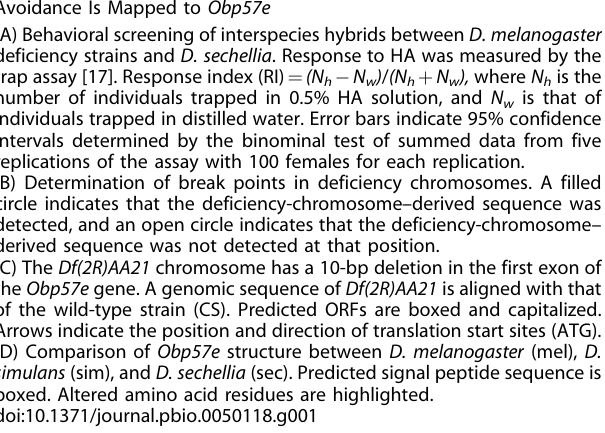
Figure 1. The Locus Responsible for Interspecies Difference in HA Avoidance Is Mapped to Obp57e (A) Behavioral screening of interspecies hybrids between D. melanogaster deficiency strains and D. sechellia . Response to HA was measured by the trap assay [17]. Response index (RI) ¼ (N h (cid:2) N w ) / (N h þ N w ), where N h is the number of individuals trapped in 0.5% HA solution, and N w is that of individuals trapped in distilled water. Error bars indicate 95% confidence intervals determined by the binominal test of summed data from five replications of the assay with 100 females for each replication. (B) Determination of break points in deficiency chromosomes. A filled circle indicates that the deficiency-chromosome–derived sequence was detected, and an open circle indicates that the deficiency-chromosome– derived sequence was not detected at that position. (C) The Df(2R)AA21 chromosome has a 10-bp deletion in the first exon of the Obp57e gene. A genomic sequence of Df(2R)AA21 is aligned with that of the wild-type strain (CS). Predicted ORFs are boxed and capitalized. Arrows indicate the position and direction of translation start sites (ATG). (D) Comparison of Obp57e structure between D. melanogaster (mel), D. simulans (sim), and D. sechellia (sec). Predicted signal peptide sequence is boxed. Altered amino acid residues are (Figure 3E), indicating that the function of the D. sechellia